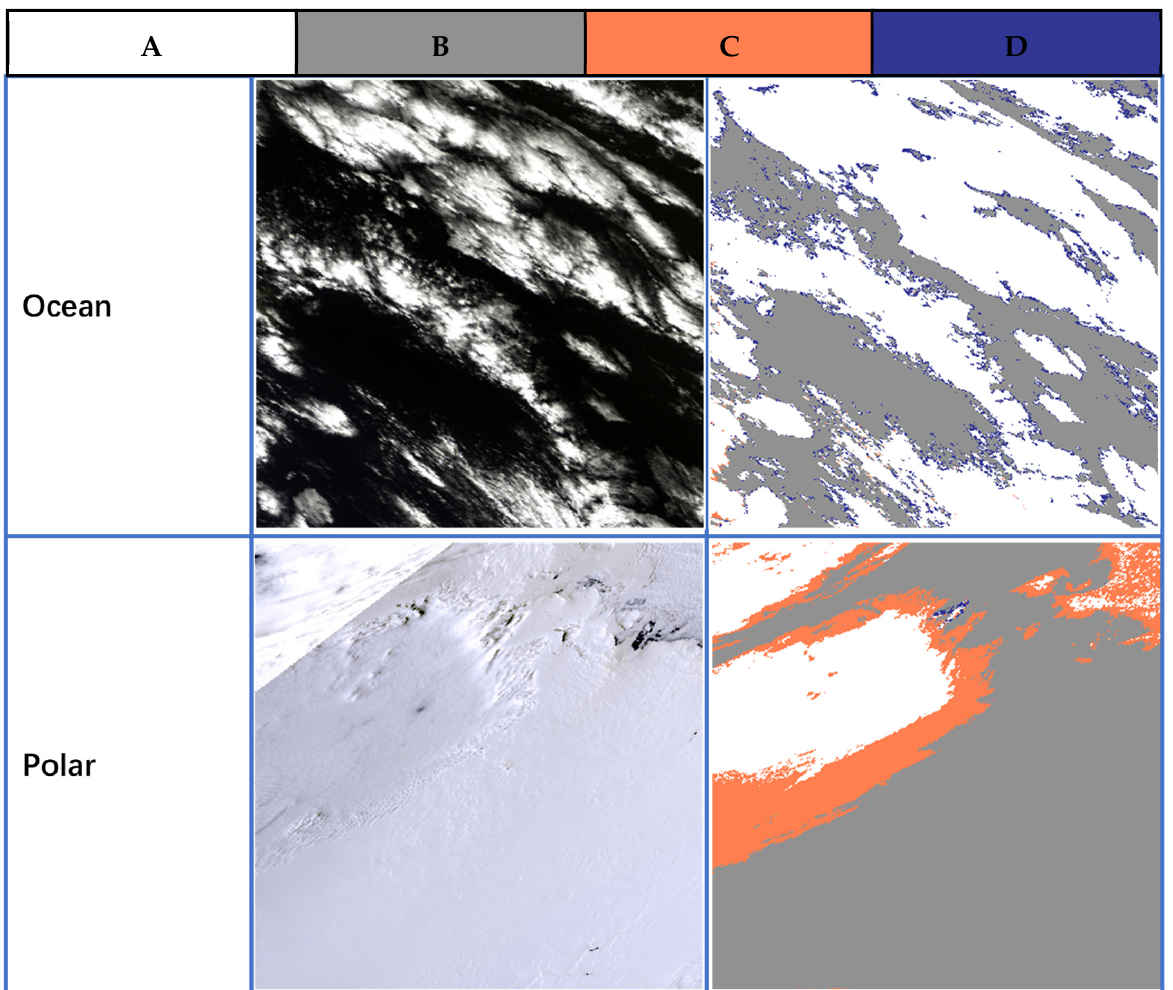
Figure 10. Same as Figure 9, but Line 1: Case over ocean at T0629 10 March 2018 for SGLI. Line 2: Case over snow at T1520 25 December 2018 for SGLI. Table 8. The sites and locations of the four scenes for this verification experiment.